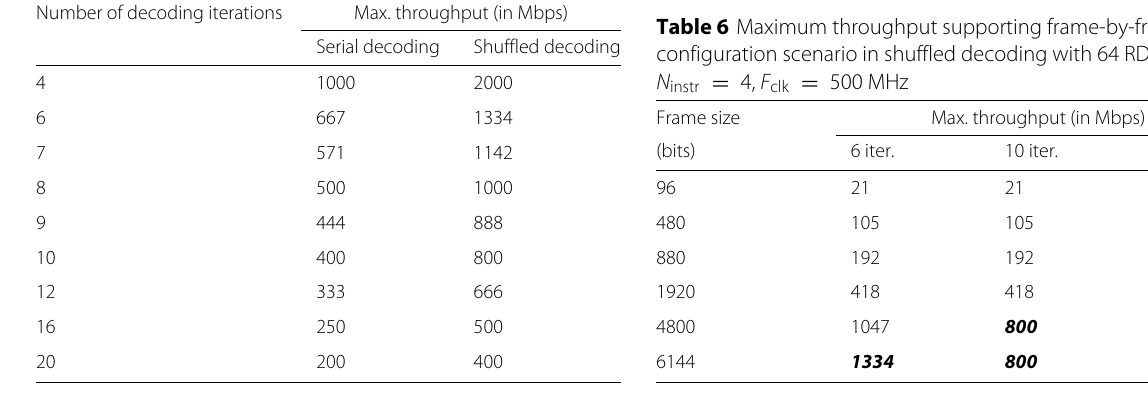
Table 6 Maximum throughput supporting